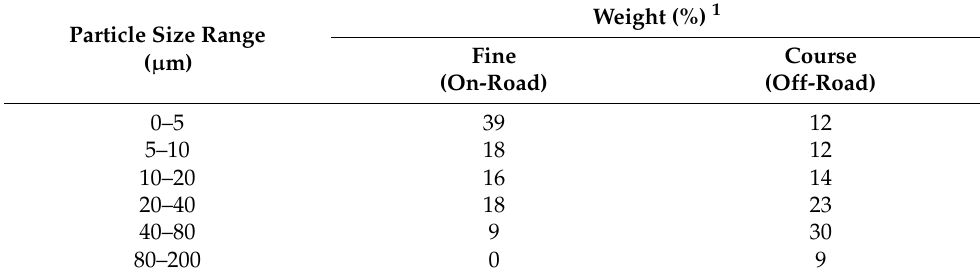
Table 2. Dust particle size distribution according to driving environment from ISO 12103-1 [11].